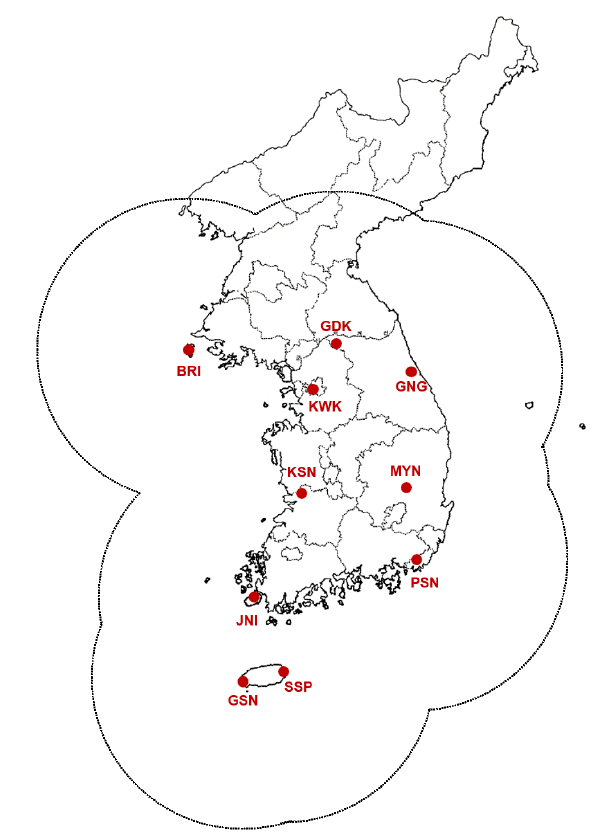
Figure 1. Ten dual-polarization radar locations and their observation ranges in